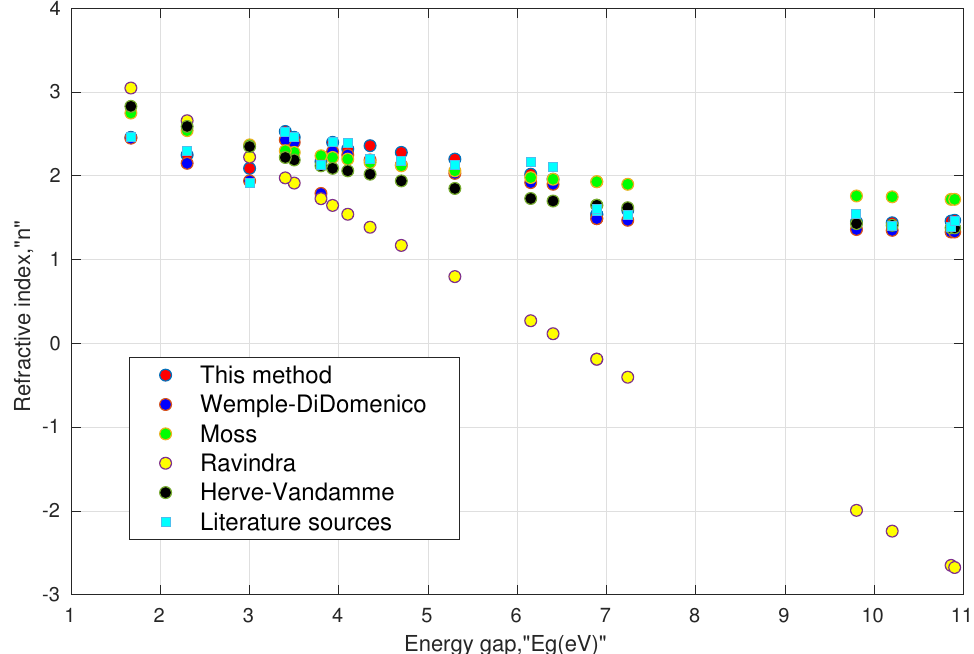
Figure 1. Comparison of various models with available literature data for perovskites, shown in Table